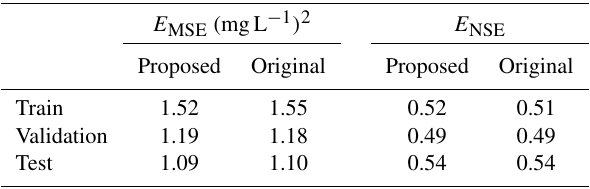
Table 3. The E MSE and E NSE for each subset of the fuzzy neural network using the method proposed (using fuzzy inputs) and using the original method (using crisp